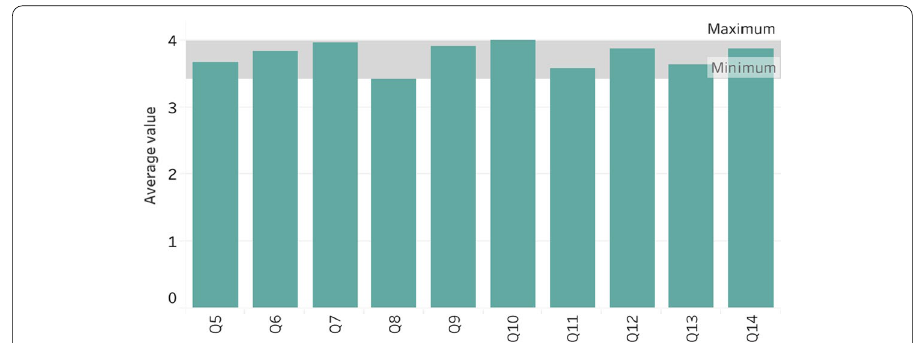
Fig. 12 Average score of each question